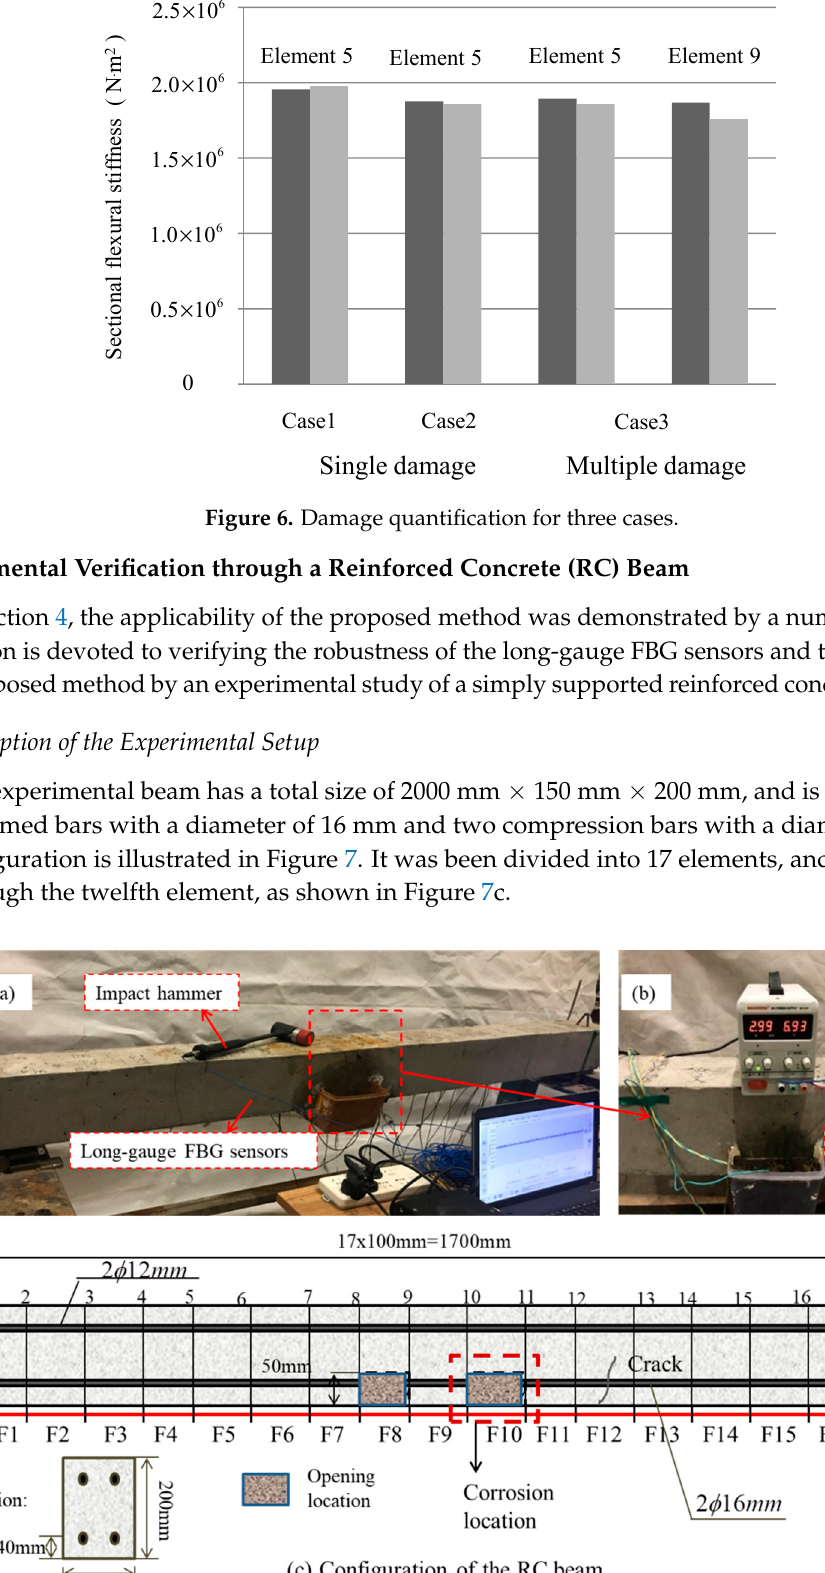
11 of 19 Table 1. Damage quantification results. Damage Location